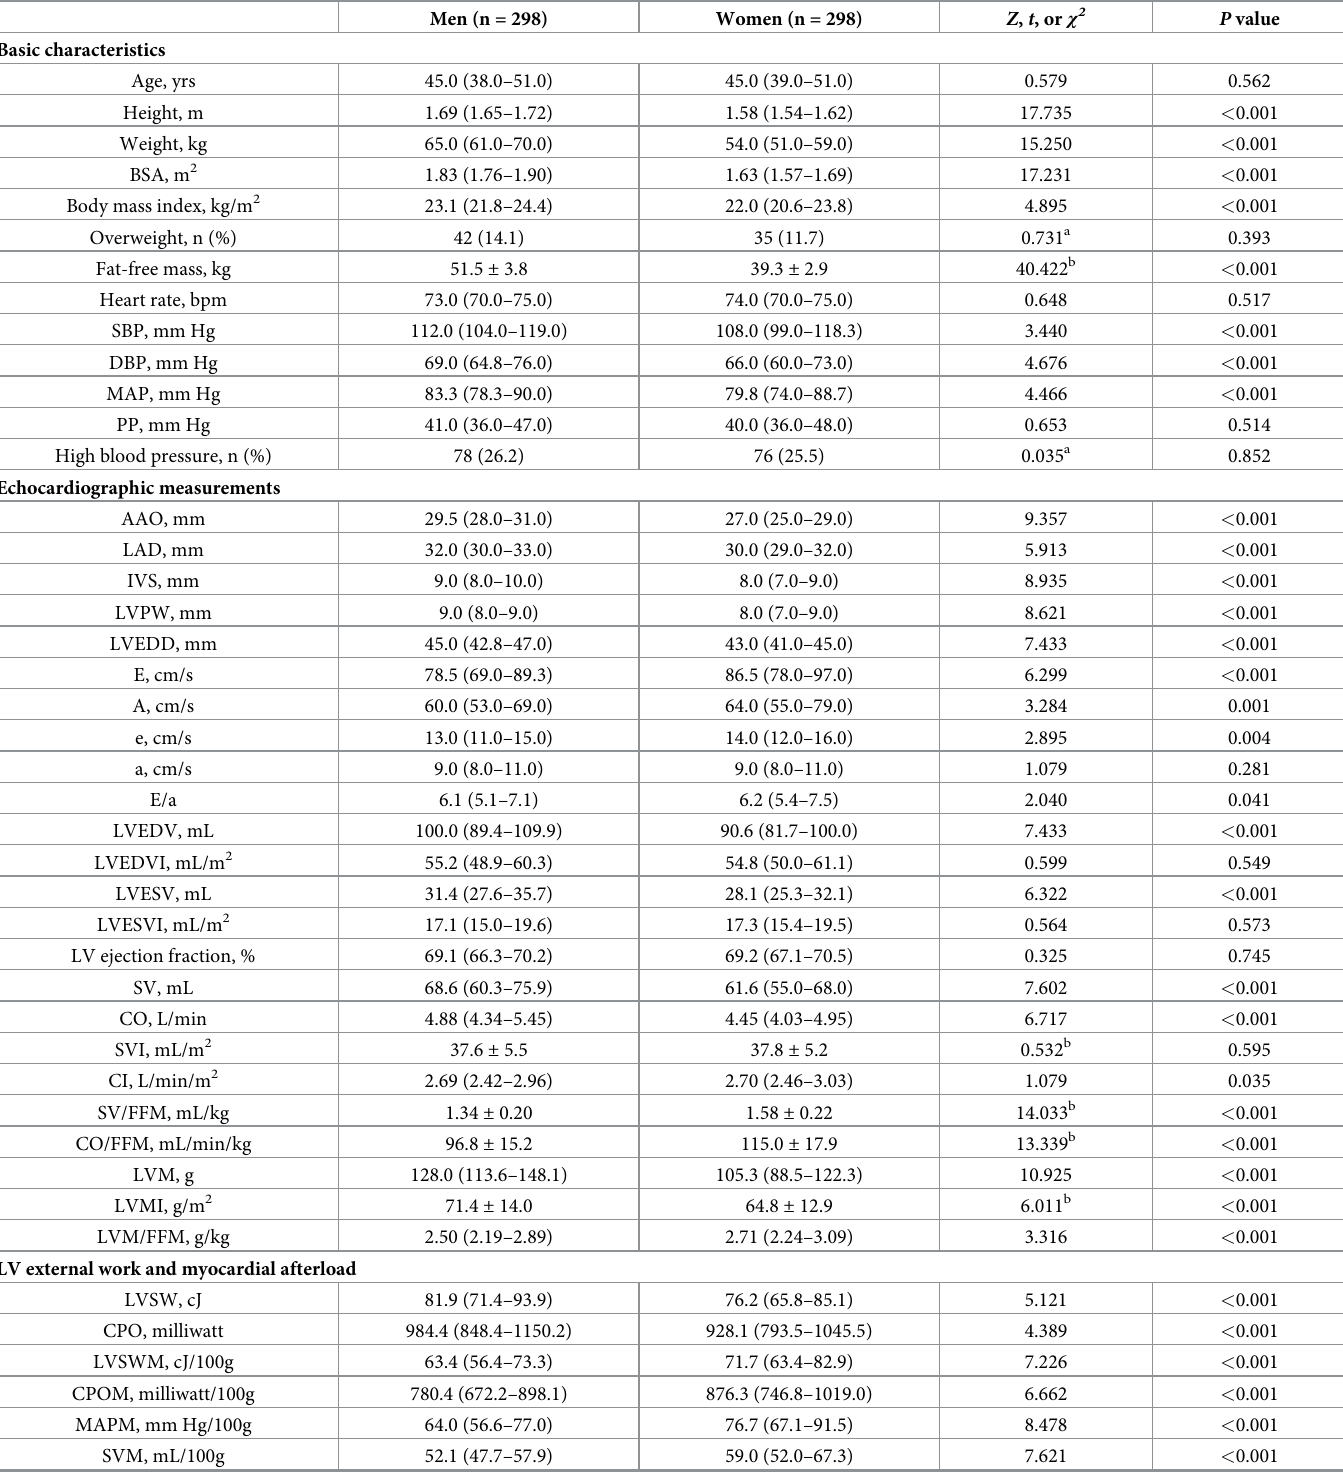
Table 1. Sex differences in basic characteristics, blood pressure, LV volume and mass, and LV external work in 596 apparently healthy